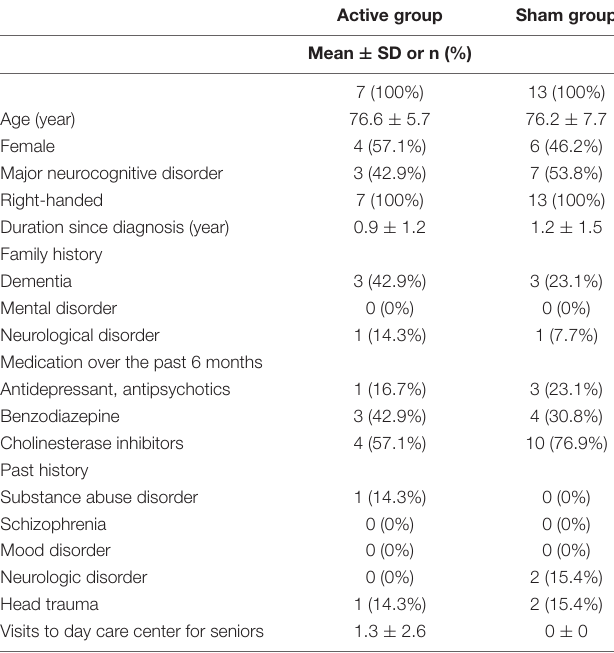
conducted from July 2016 until July 2017 because more than 20 participants finished follow-up examinations. 20 participants were included for statistical analysis.